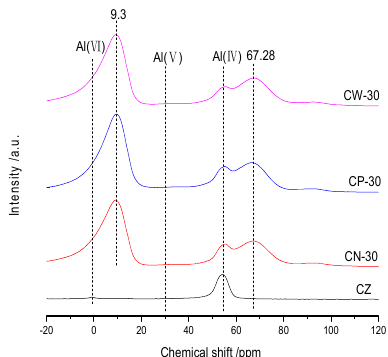
Figure 3. 27 Al NMR spectra of the catalysts.